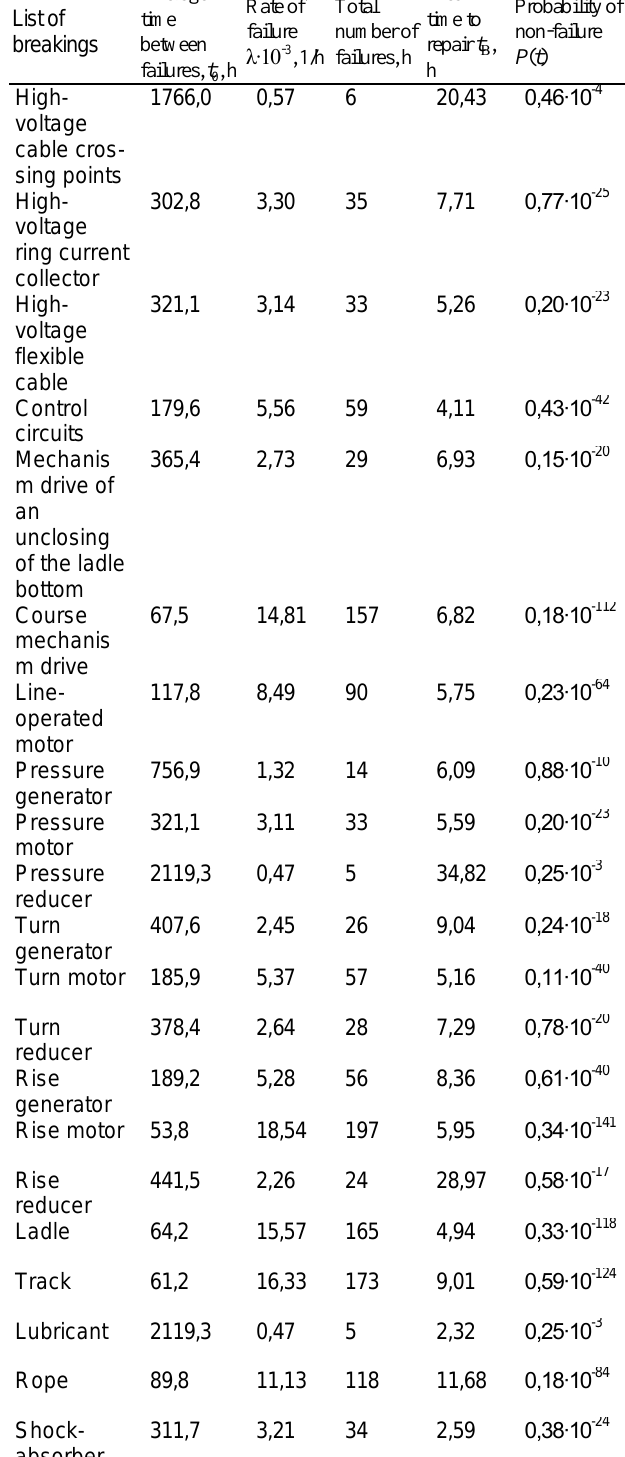
Table 3. Indexes of reliability of separate clusters and details of rope shovels of Kedrovsky open-pit mine for 2014 -